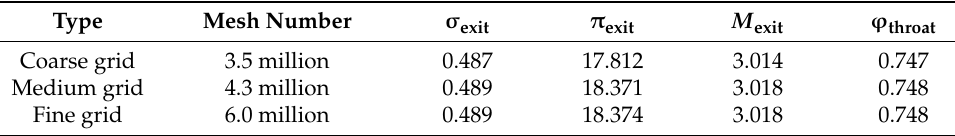
Figure 11. Structured mesh of the new spillage ‐ adaptive bump inlet. Table 1. Gird independence analysis ( M ∞ = 6.0, H = 24 km).